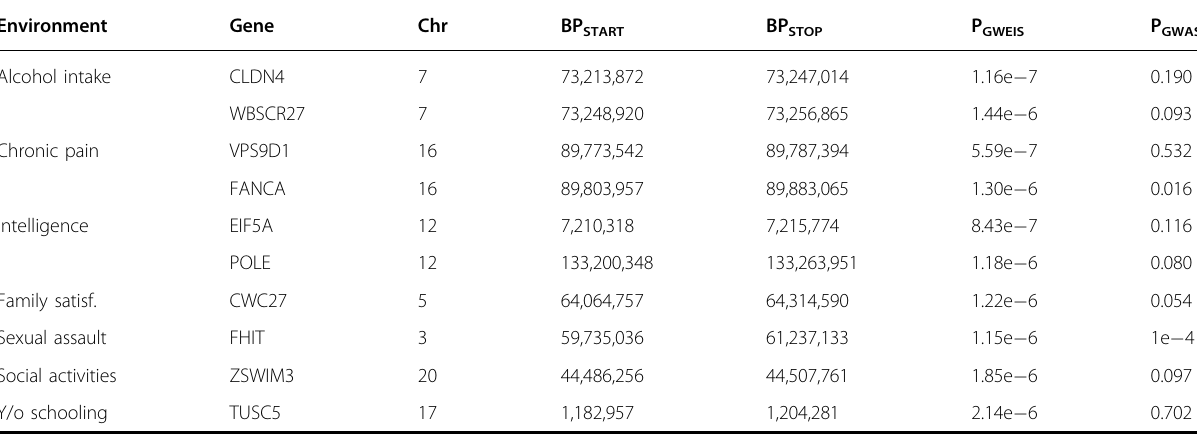
Table 3 Genes detected in the MAGMA gene analyses.